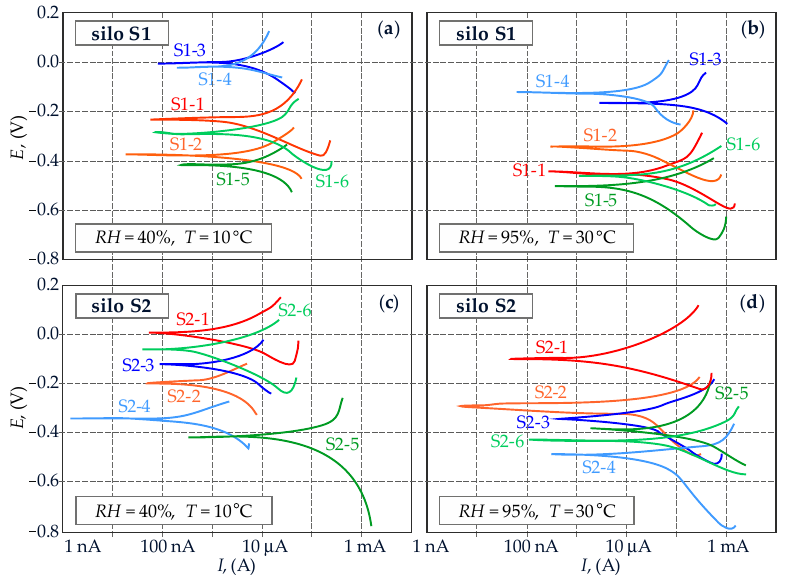
Figure 10. Polarization curves obtained with the method of the linear polarization curve (LPR) performed on cylindrical concrete cores with fragments of steel rebars, drilled from the structure of reinforced concrete silos for cement storage: ( a ) results for the silo S1—tests at air temperature T = 10 ◦ C and relative humidity RH = 40%; ( b ) results for the silo S1—tests at air temperature T = 30 ◦ C and relative humidity RH = 95%; ( c ) results for the silo S2—tests at air temperature T = 10 ◦ C and relative humidity RH = 40%; and ( d ) results for the silo S2—tests at air temperature T = 30 ◦ C and relative humidity RH = 95%.